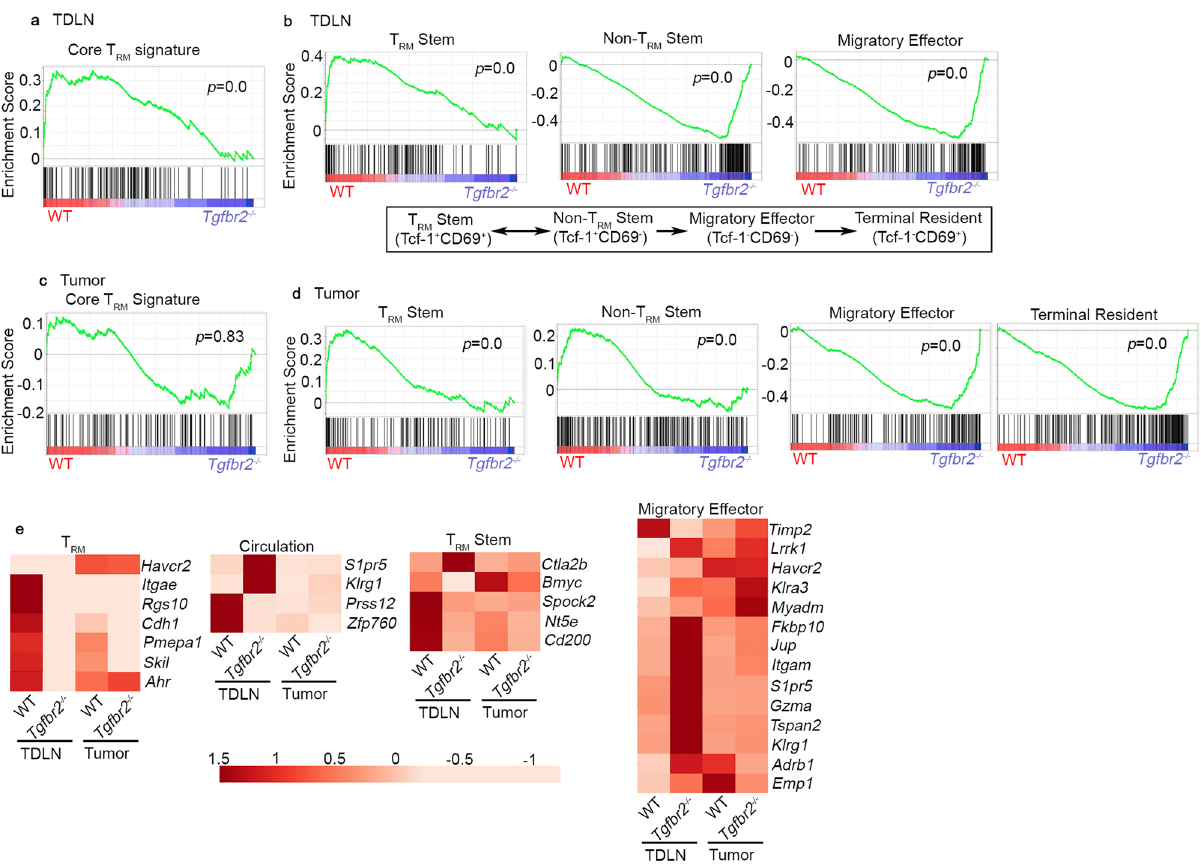
Fig. 9 | Enhanced differentiation from T RM stem to non-T RM stem in TDLN and accumulation of migratory effectors in tumor for Tgfbr2 − / − Pmel-1 T cells. Bulk RNA-seq was performed on sorted Pmel-1 T cells isolated from TDLN and tumor. GSEA(genesetenrichmentanalysis)resultsareshown.Red,WTandviolet, Tgfbr2 − / − . a Core T RM signature enrichment in TDLN samples. b The signatures of exhuasted